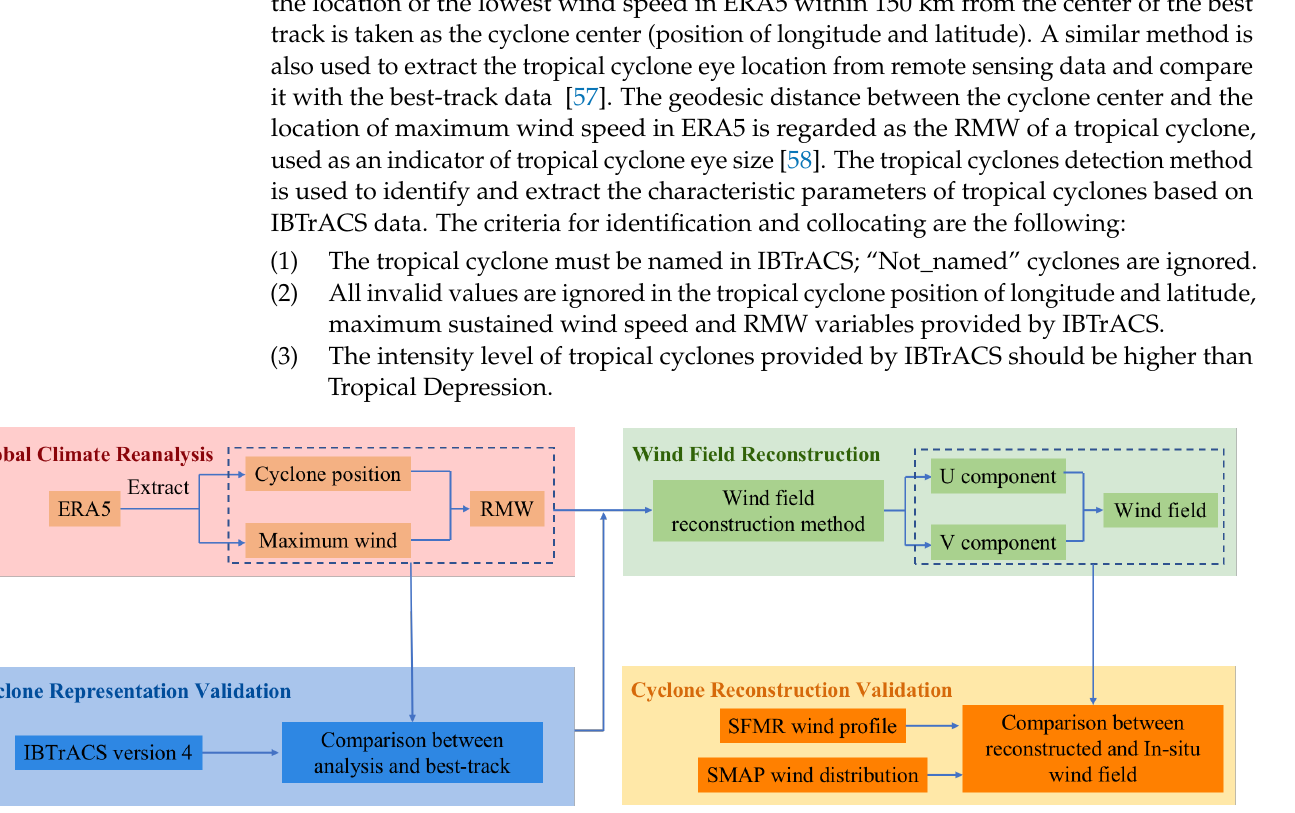
Figure 1. Flowchart of the research framework showing the ERA5 datasets (top left), tropical cyclones representation validation (bottom left), wind field reconstruction (top right) and validation (bottom